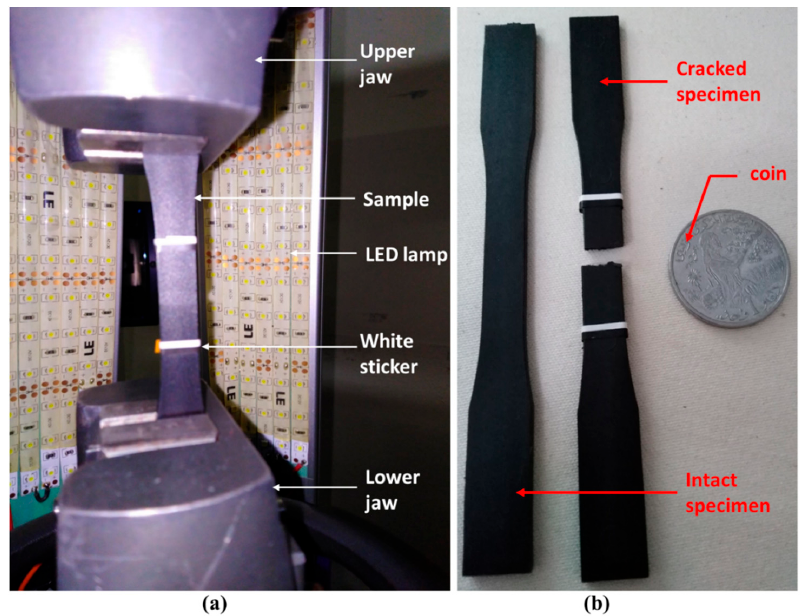
Figure 3. ( a ) Tensile test set-up; ( b ) Sample before and after